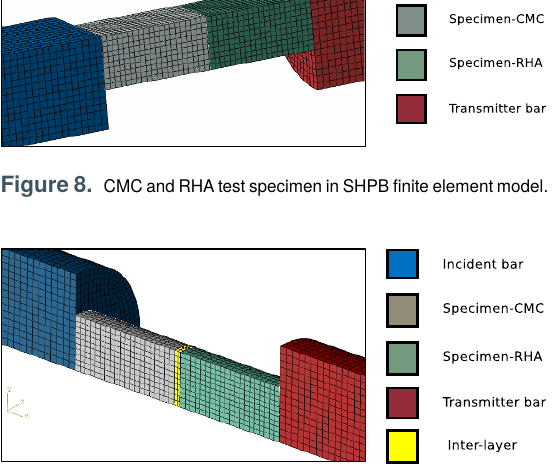
Figure 9. CMC and RHA test specimen with inter-layer in SHPB finite element